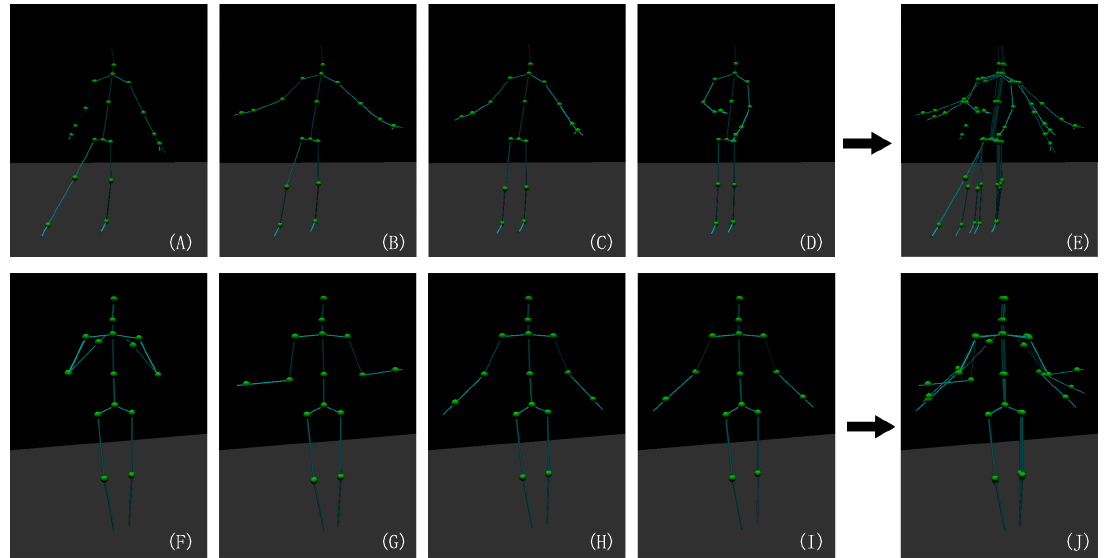
Figure 1. Motion skeleton estimates from two types of motion extraction SDKs. Upper row: The motion skeleton captured by Kinect v2.0. ( A – D ) Four frames in the a motion clip and ( E ) all of them in a single image. Bottom row: The motion skeleton captured by Intel RealSense D435 with the Nuitrack SDK. ( F – I ) Four frames in a motion clip and ( J ) all of them in a single image. This demonstrates that the respective skeleton estimates vary significantly regarding the bone length during the